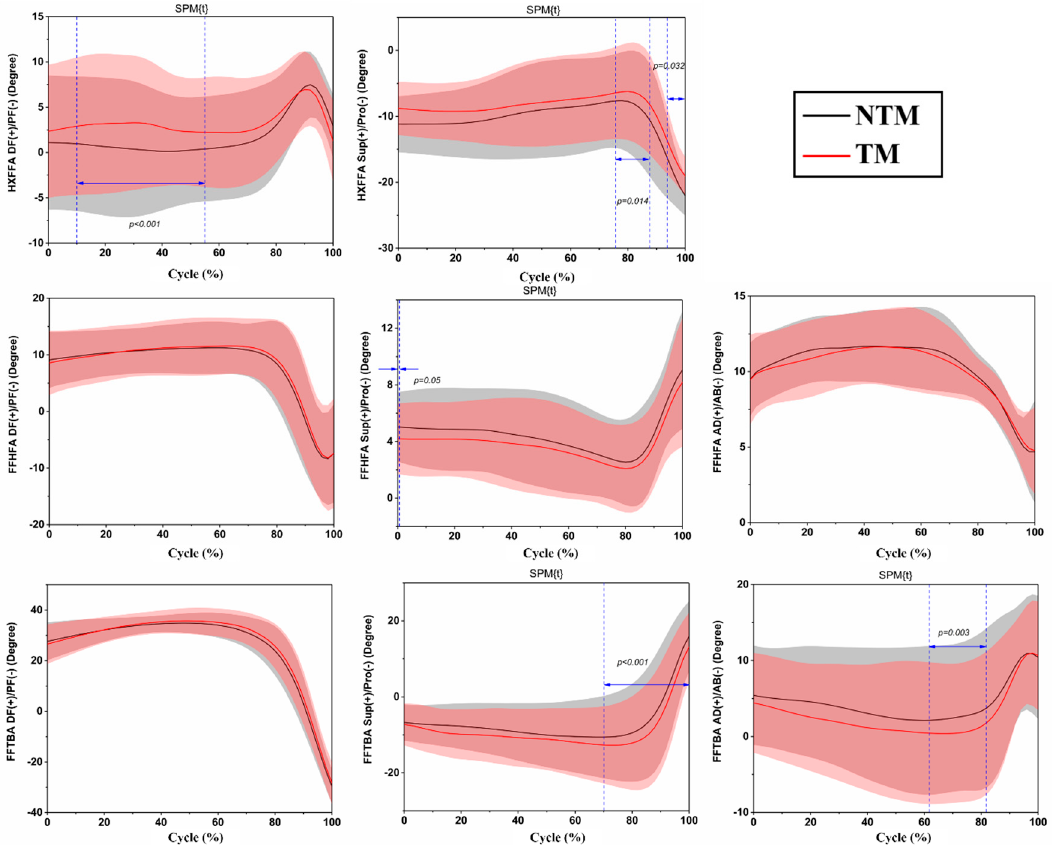
Figure 2. The foot inter-segment angle differences during take-off in Non-Toe-Manipulation ( NTM ) and Toe-Manipulation ( TM ) sessions. Blue lines highlighted areas indicate significant differences according to spm1d with p < 0.05. Abbreviations: DF: dorsiflexion, PF: plantarflexion, Sup: supination, Pro: pronation, AD: adduction, AB: abduction, Inv: inversion, Ev: eversion, Int.: internal rotation, Ext.: external rotation.